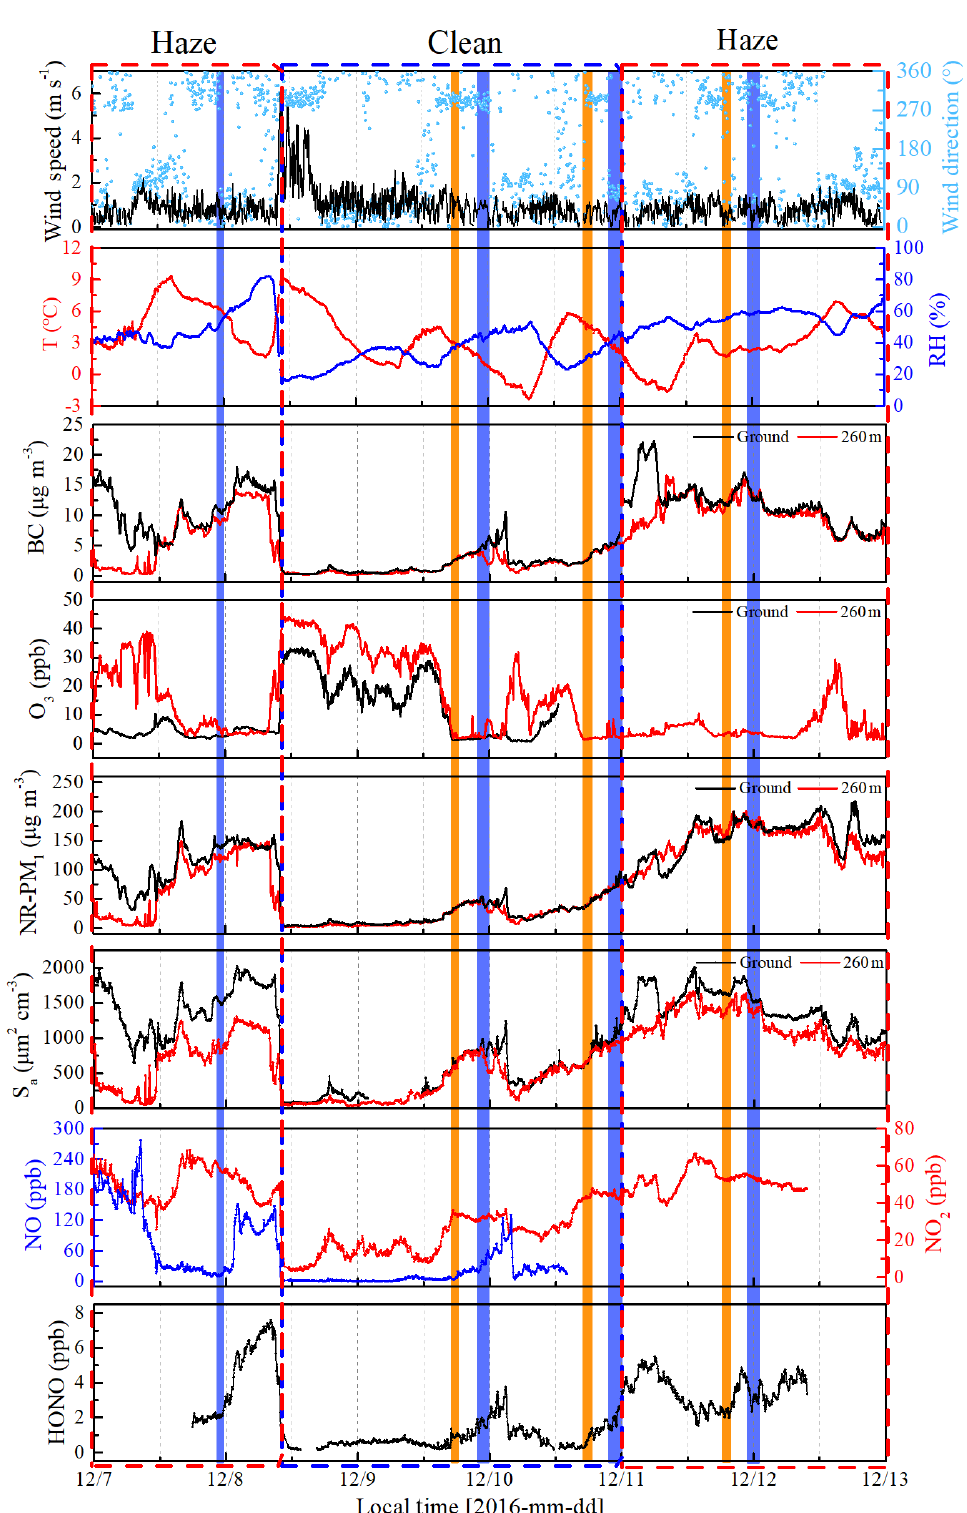
Figure 3. Time series of wind speed (WS) and direction (WD), temperature ( T ), relative humidity (RH), BC, O 3 , NR-PM 1 , aerosol surface area ( S a ), NO, NO 2 , and HONO from 7 to 12 December 2016 at the IAP Tower Division in Beijing, China. The measurements of NO, NO 2 , and HONO are made at the ground level. The shaded region represents the eight vertical measurements (Table S1). The orange shaded region represents the vertical measurements after sunset, and the violet shaded region represents the vertical measurements at night and